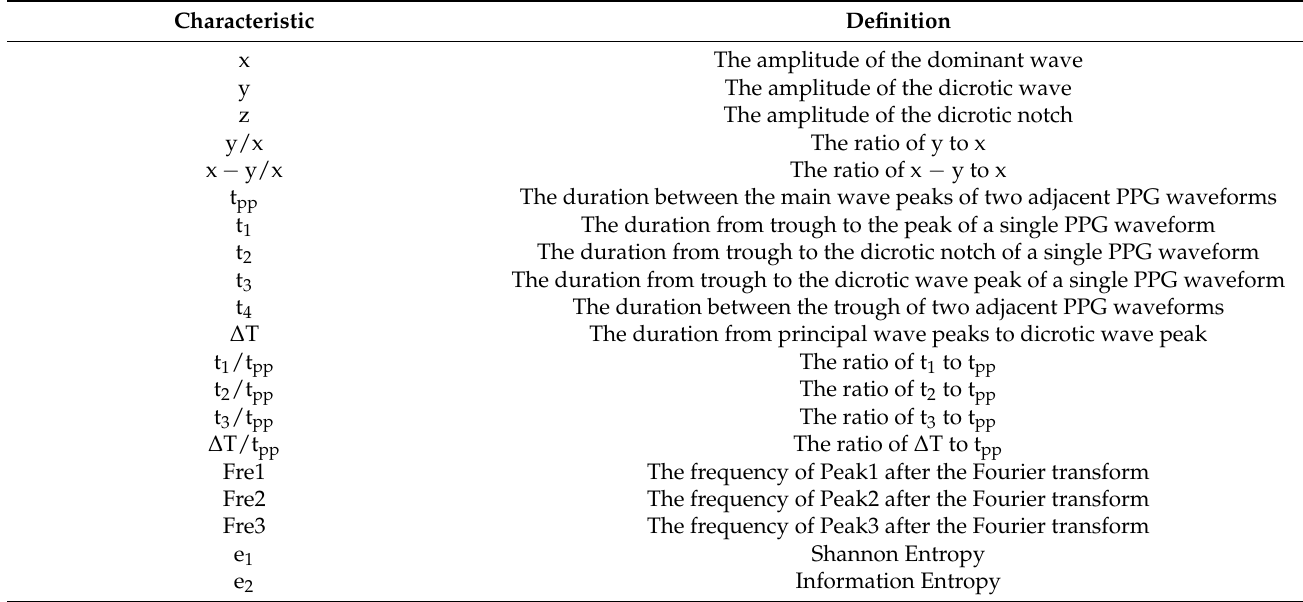
Table 6. Time domain and frequency domain characteristics of